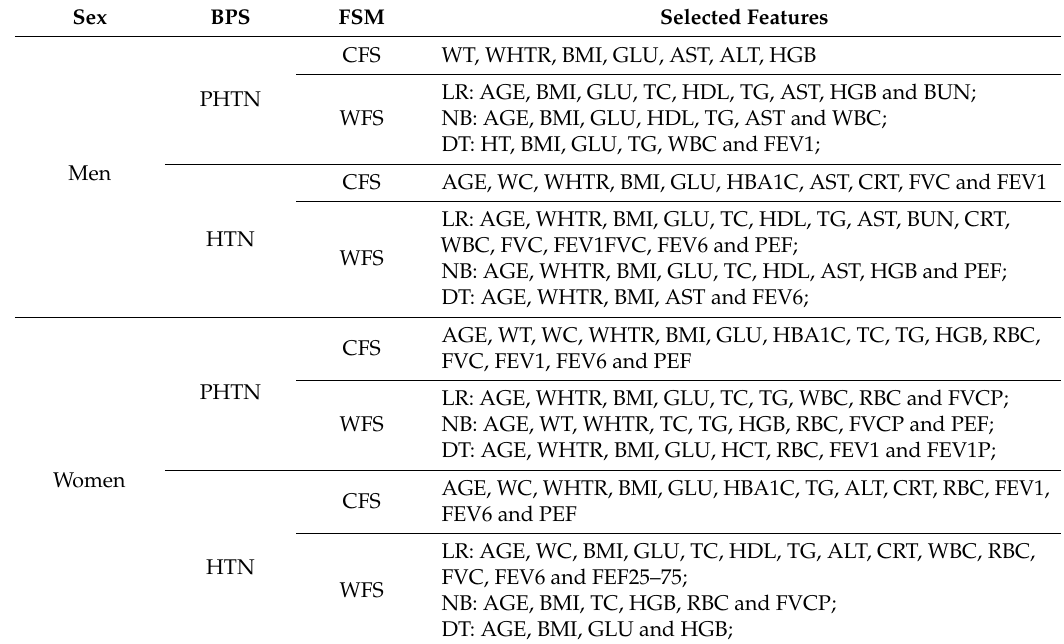
Table 4. Details of the prediction models of prehypertension and hypertension.